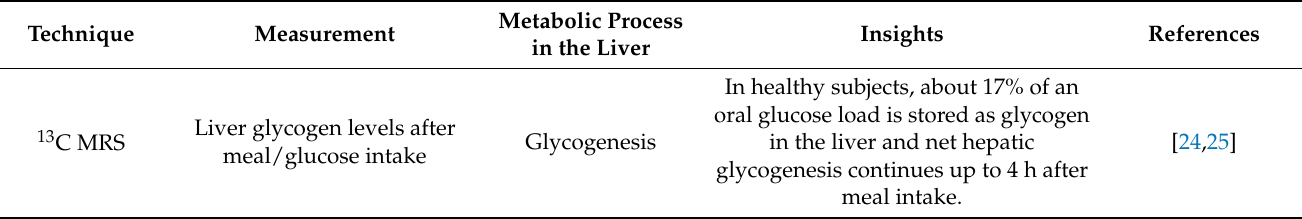
Table 1. MR techniques for assessing hepatic glucose metabolism in vivo and obtained insights in both the healthy and diabetic